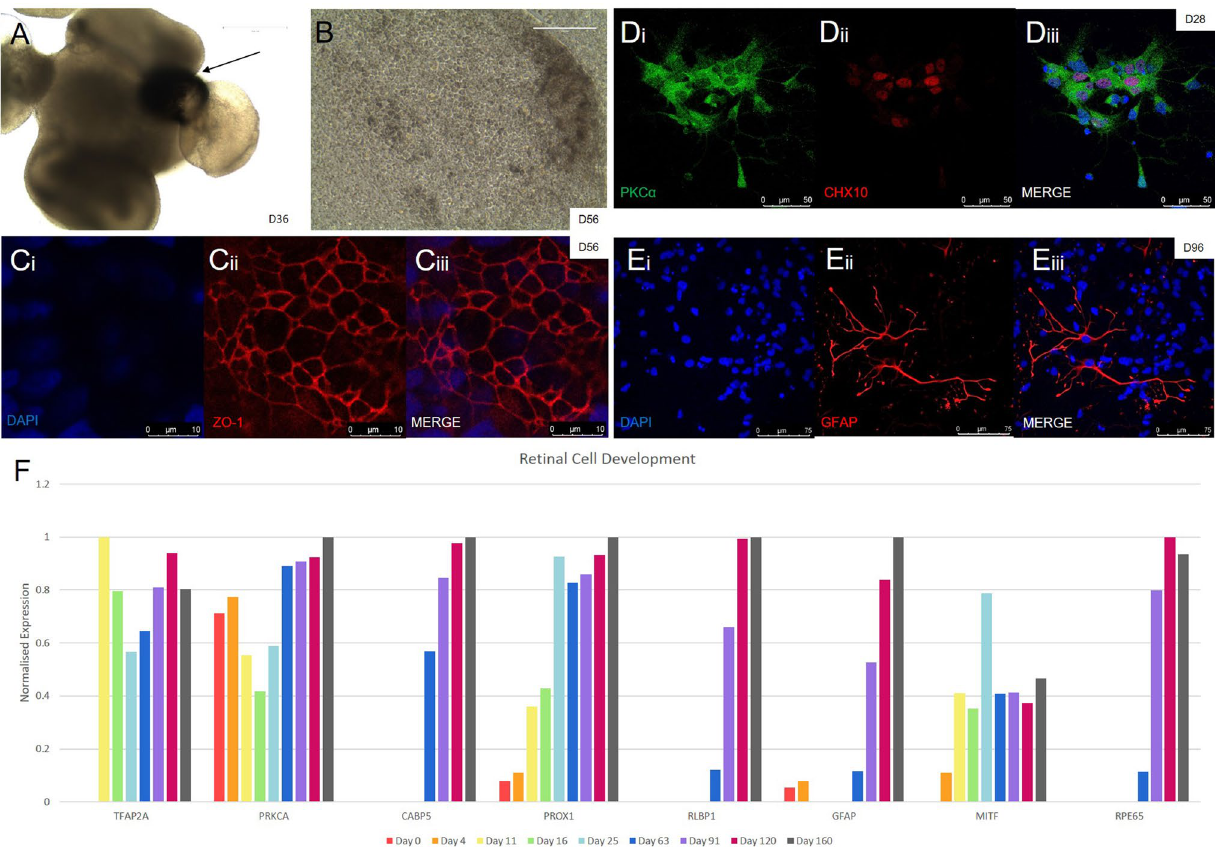
Figure 4. Generation of RPE and other retinal cell types. ( A ) A subset of organoids developed visible pigmented areas by day 36. ( B , Ci-iii ) These were dissociated and grown as a monolayer that had the characteristic cobblestone appearance and ZO-1 tight junction presence (in red) of RPE. ( Di-iii ) According to our quantitative marker data, bipolar cells appeared in culture within 4 weeks. The presence of bipolar cells was confirmed by staining for PKCα (in green) at day 28. ( Ei-iii ) Dissociated organoids grew out Müller cells, which were confirmed by staining for GFAP (in red). ( F ) In addition to bipolar, horizontal, Müller and pigmented epithelial cells, amacrine cells were also found within the organoid, suggested by RNA sequencing